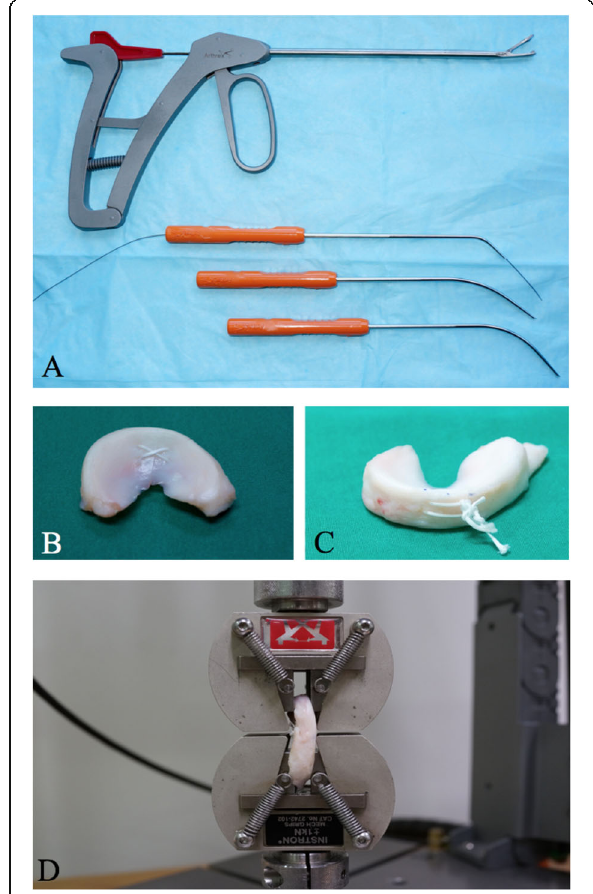
Fig. 1 a Scorpion (top) and Micro SutureLasso with different curvatures (bottom) meniscus repair devices used in the study; b Double vertical cross repair with the Scorpion device; c Double horizontal repair with the Micro SutureLasso device; c mechanical testing set